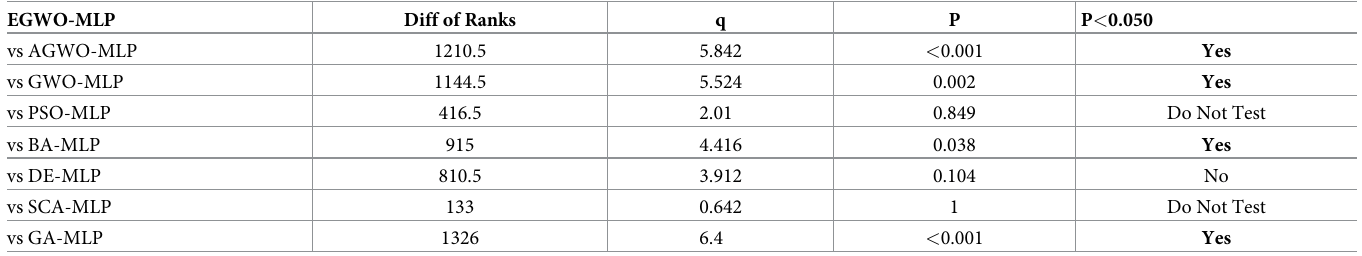
Table 5. Results for RM ANOVA on RANKS of the Mathematics (Mat.) subject achievement prediction.